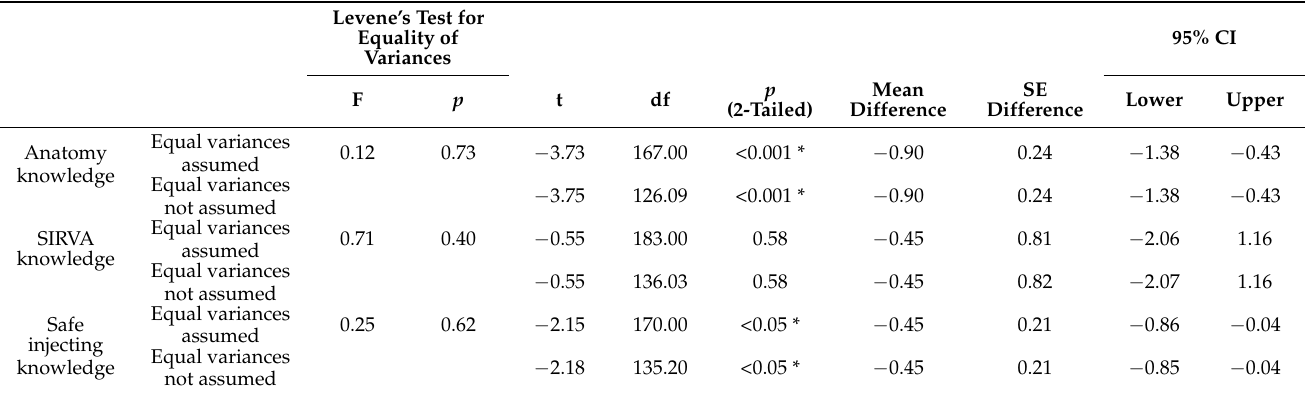
Table A3. Independent T-Test comparing knowledge levels of immunising professions with non- immunising